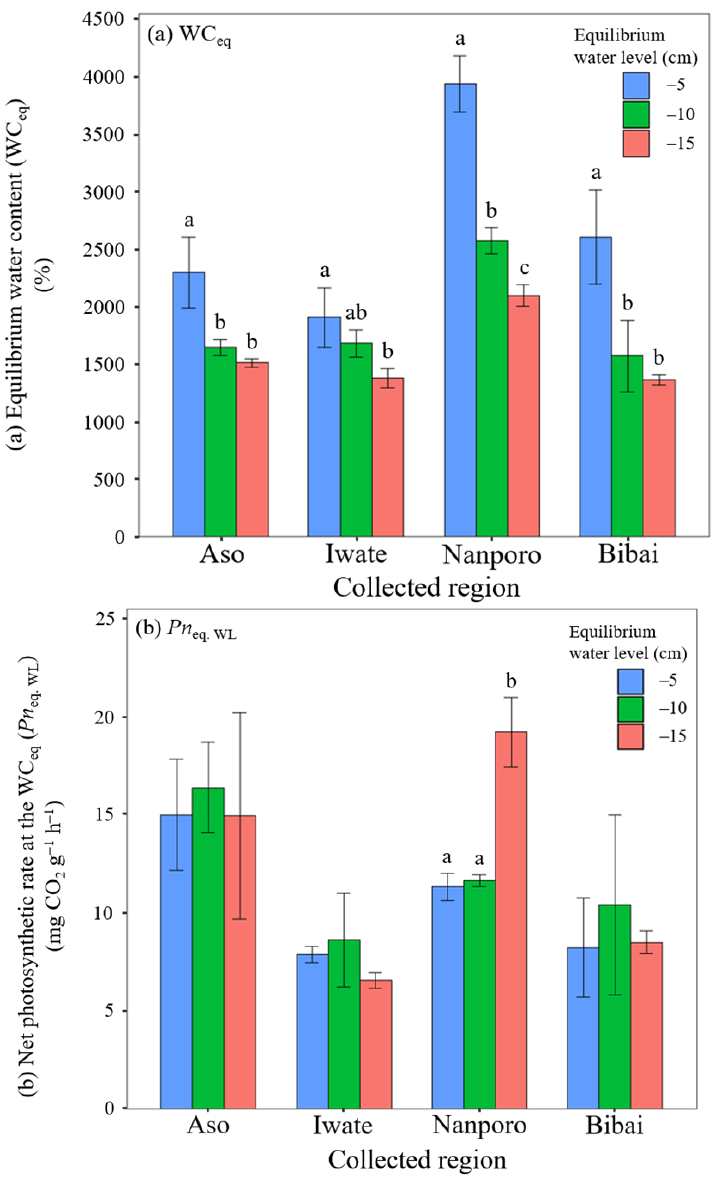
Figure 6. Comparison of (a) equilibrium water content for the water level (WC photosynthetic rate at WC ( Pn ; mg CO g –1 h –1 ) of Sphagnum palustre from Aso, Iwate, Nanporo, and eq eq.WL 2 Bibai. The error bars denote standard deviation ( n = 3), except for the sample from Bibai at -10 cm ( n =